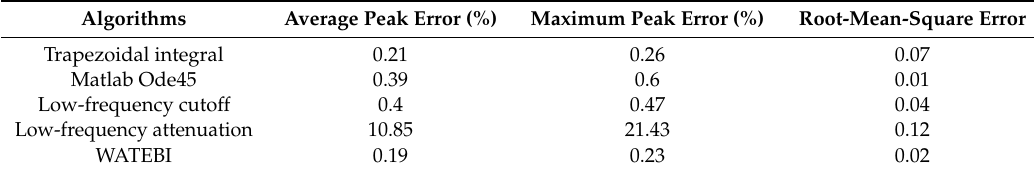
Table 2. Five methods for the displacement reconstruction of SDOF